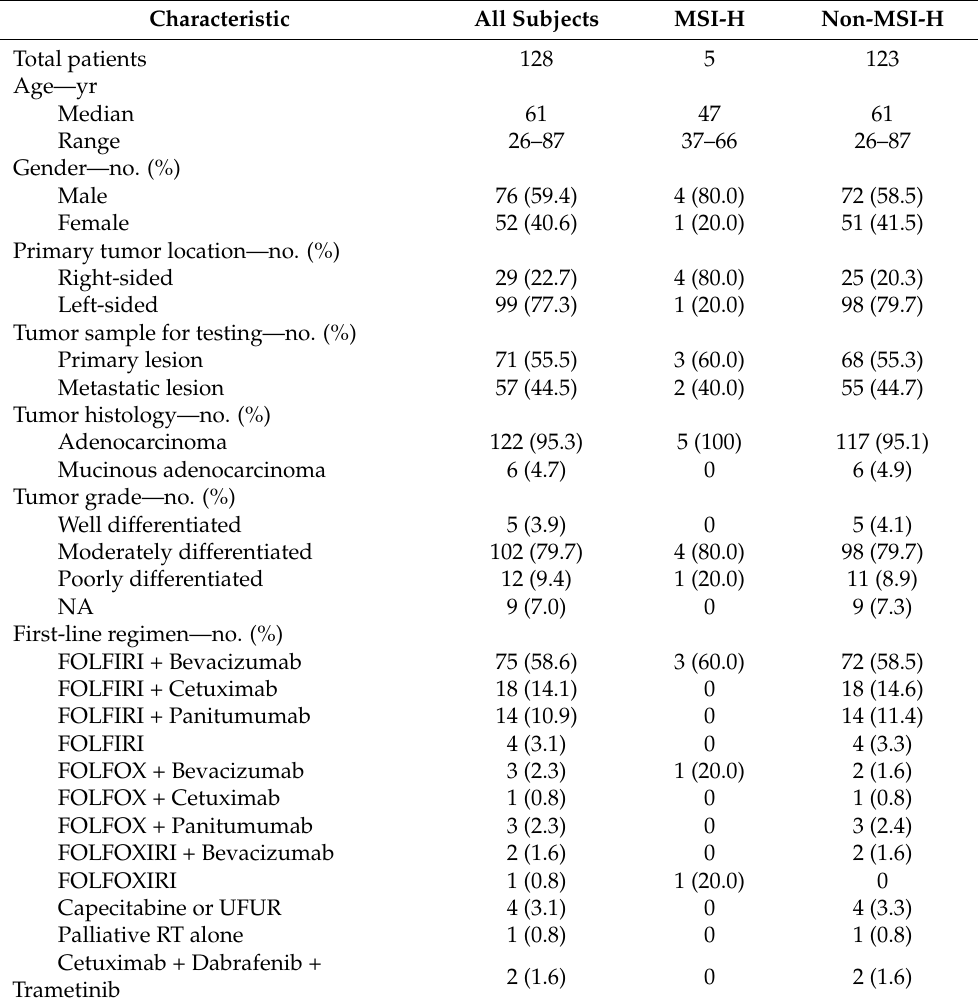
Table 1. Clinical characteristics of the 128 mCRC